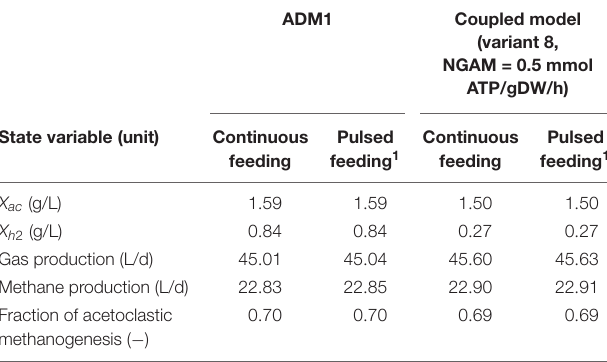
TABLE 5 | Steady-state simulation results for the dynamic simulation of continuous and pulsed feeding, both featuring identical daily substrate input rates.